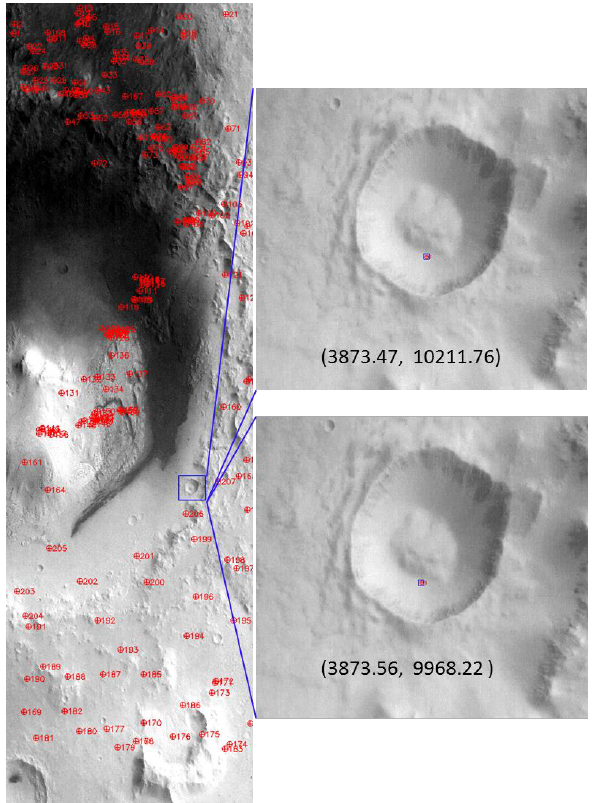
Figure 8. The distribution of corresponding points in HRSC stereo images (left); A corresponding point pair in image